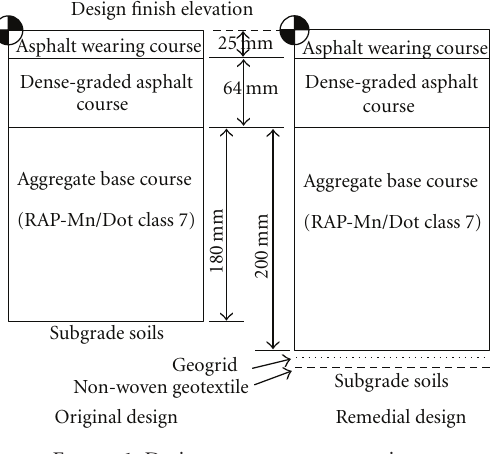
Figure 1: Design pavement cross sections.